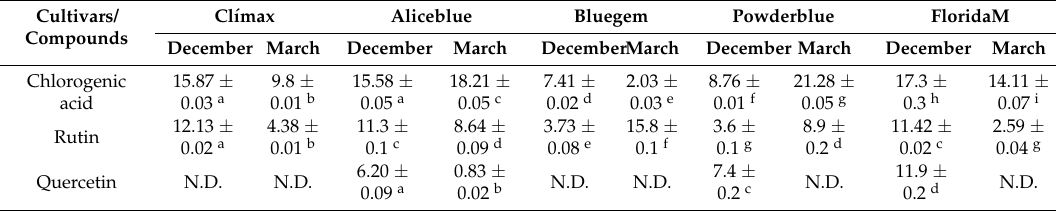
Table 2. Phenolic compounds blueberry contents of rabbiteye leaves from different harvesting months and cultivars by HPLC-UV/DAD 1